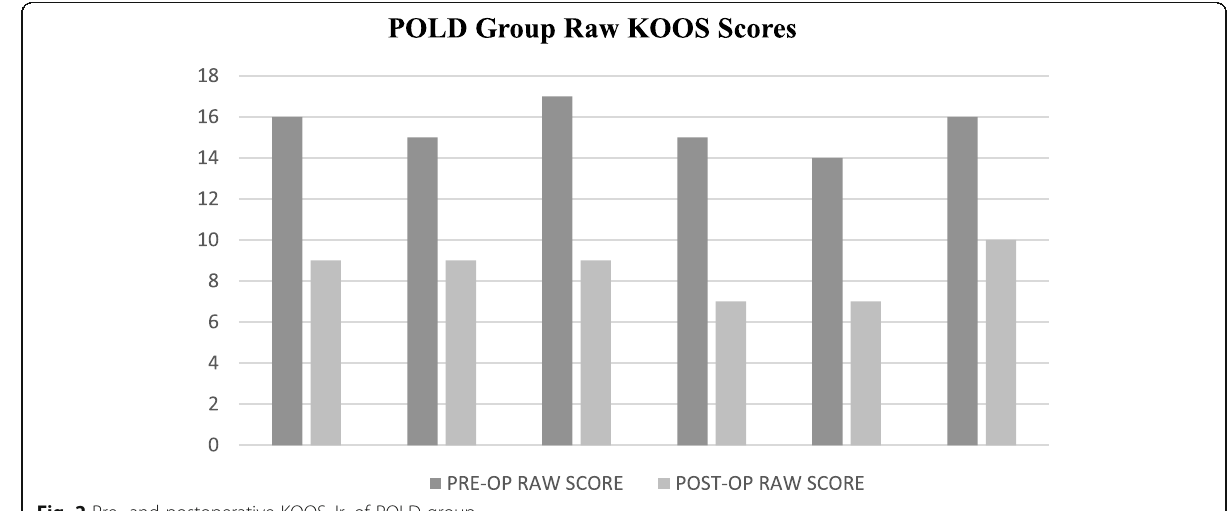
Fig. 2 Pre- and postoperative KOOS Jr. of POLD